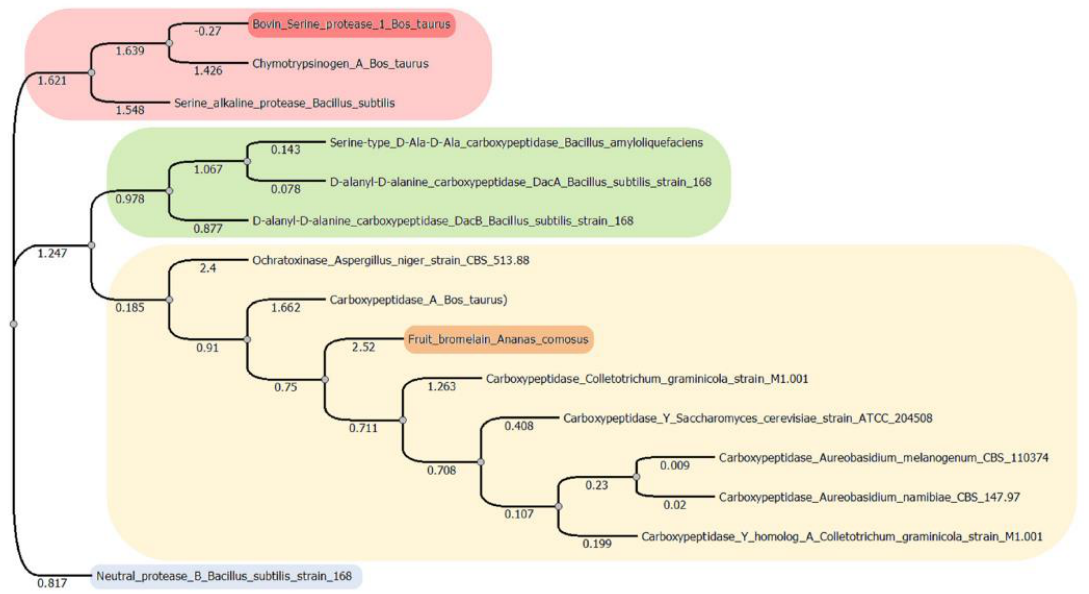
Figure 1. Phylogenetic tree showing genetic distance distribution of OTA hydrolysing enzymes (original figure). The tree was constructed using multiple sequence alignment (MSA). Sequences belong to the three studied enzymes in this study: bovine serine protease (highlighted in red), fruit bromelain ( Ananas comosus ; highlighted in orange) and neutral metalloendopeptidase ( Bacillus subtillis ; highlighted in blue); and those taken from previous studies found to bio transform OTA: chy- motrypsin ( Bos taurus [26]); serine alkaline protease ( Bacillus subtillis [28]); Serine type D-Ala-D-Ala carboxypeptidase ( Bacillus amyloliquefaciens [31]); D-alanyl-D-alanine carboxypeptidase DacA strain 168 ( Bacillus subtillis [35]); D-alanyl-D-alanine carboxypeptidase DacB strain 168 ( Bacillus subtillis [35]); ochratoxinase strain CBS513.88 ( Aspergillus niger [24]); carboxypeptidase A ( Bos taurus [21,26]);